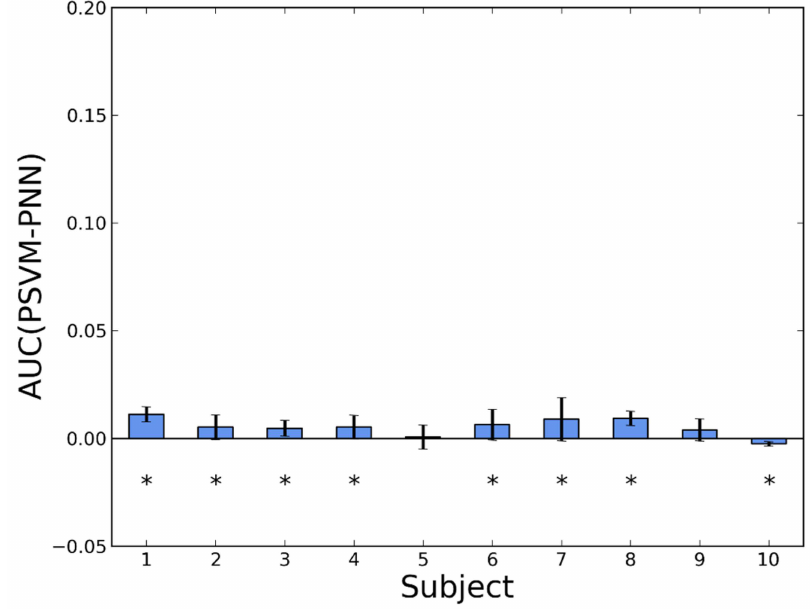
Figure 6. Difference in AUC between the personalized versions of SVM (PSVM) and NN (PNN). Whiskers represent standard deviations. Asterisks indicate p -values < 0.05 in a Wilcoxon